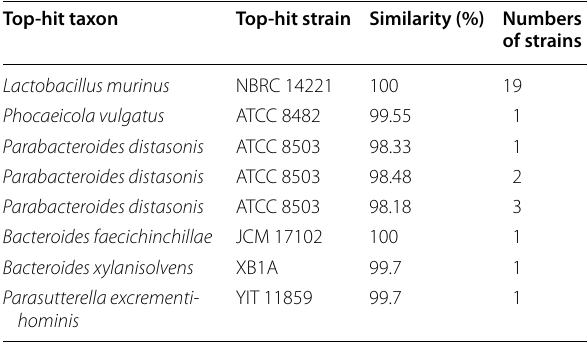
Table 4 Strain information of isolates from TSA medium with 8% defidrinated sheep’s